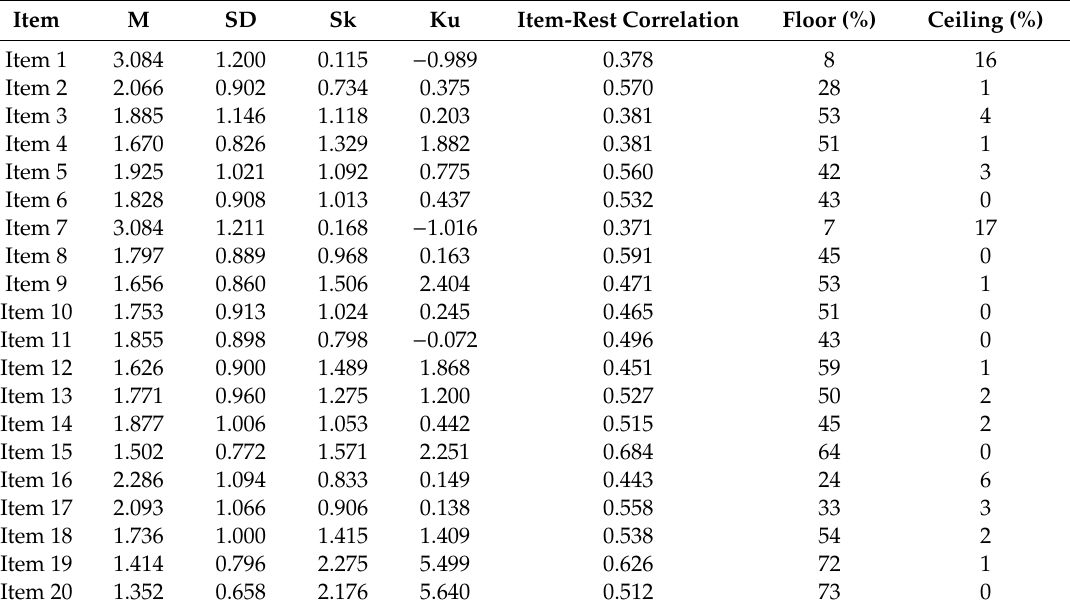
Table 3. Item analysis for the Internet Addiction Test